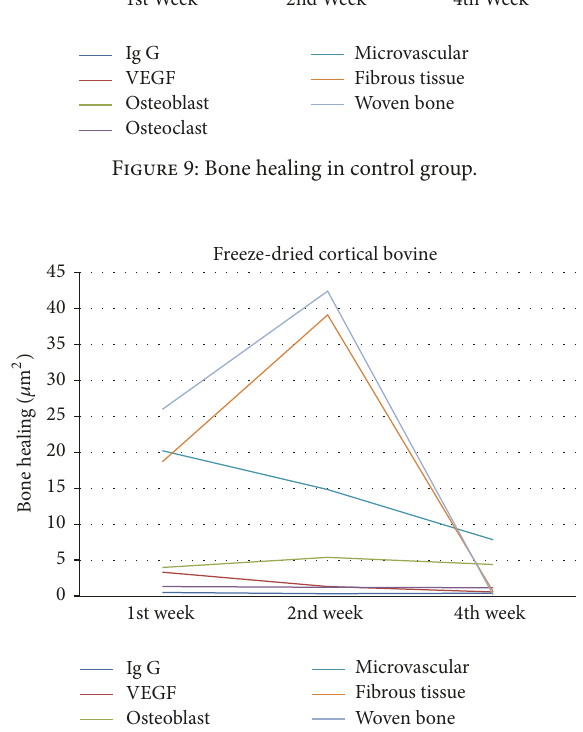
Figure 12: Bone healing in bovine hydroxyapatite